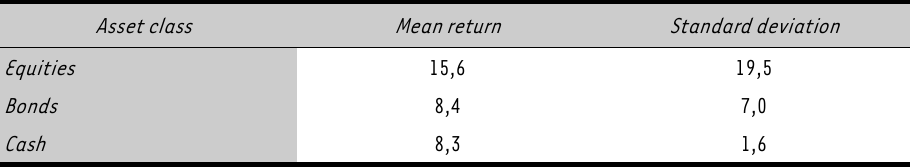
Summary of returns and standard deviations for the asset classes Asset class Mean return Standard deviation Equities 15,6